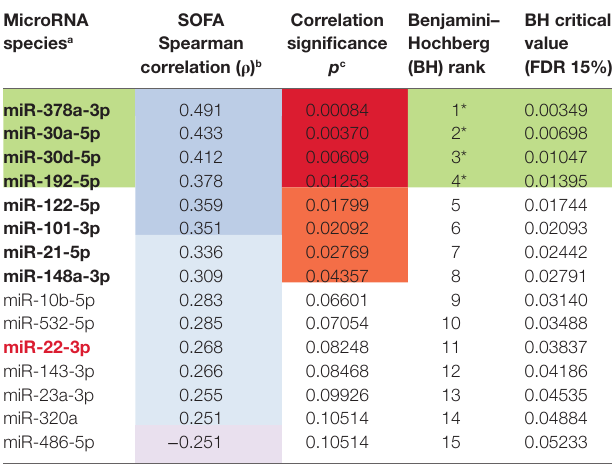
TaBle 1 | Correlations of circulating inflammatory-relevant microRNAs (CIR- miRNAs) with severity of systemic inflammatory response syndrome (SIRS) as detected by sequential organ failure assessment (SOFA).